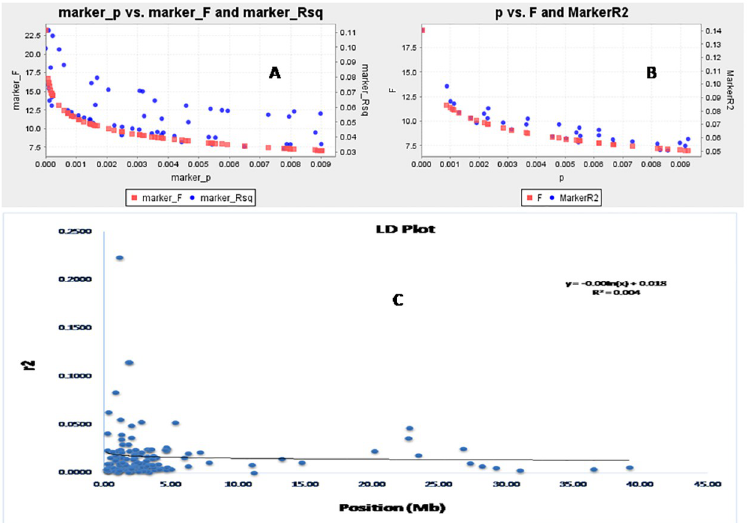
Fig 6. The marker ‘P’ versus marker ‘F’ and marker R 2 detected using (A) GLM approach (B) MLM approach and (C)The physical distance (Mb) between pairs of loci on chromosomes against linkage disequilibrium (LD) decay ( r 2 ) curve plotted in rice. The decay started in million bp estimated by taking 95 th percentile of the distribution of r2 for all unlinked loci.